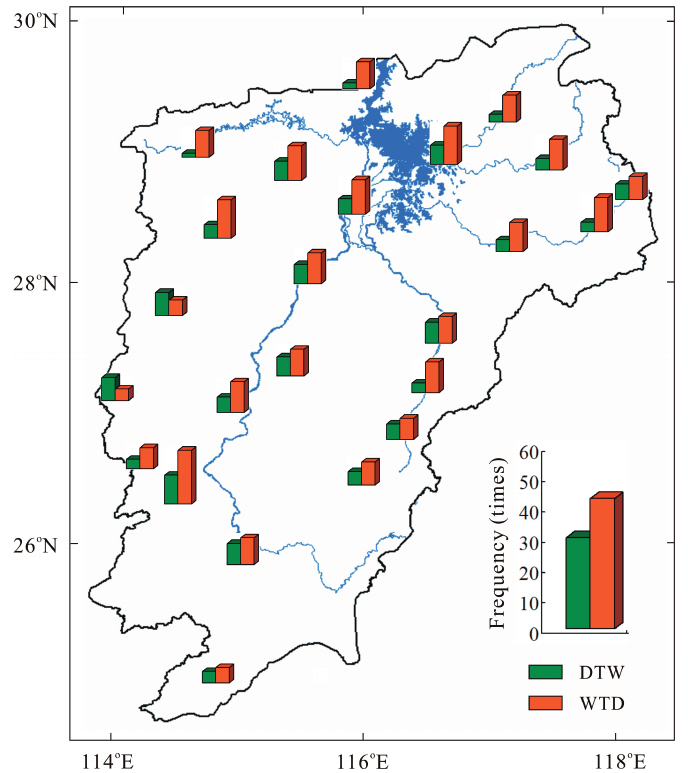
Figure 8. Spatial distribution of the occurrence frequency of DWAT events. DTW, dry to wet; WTD, wet to